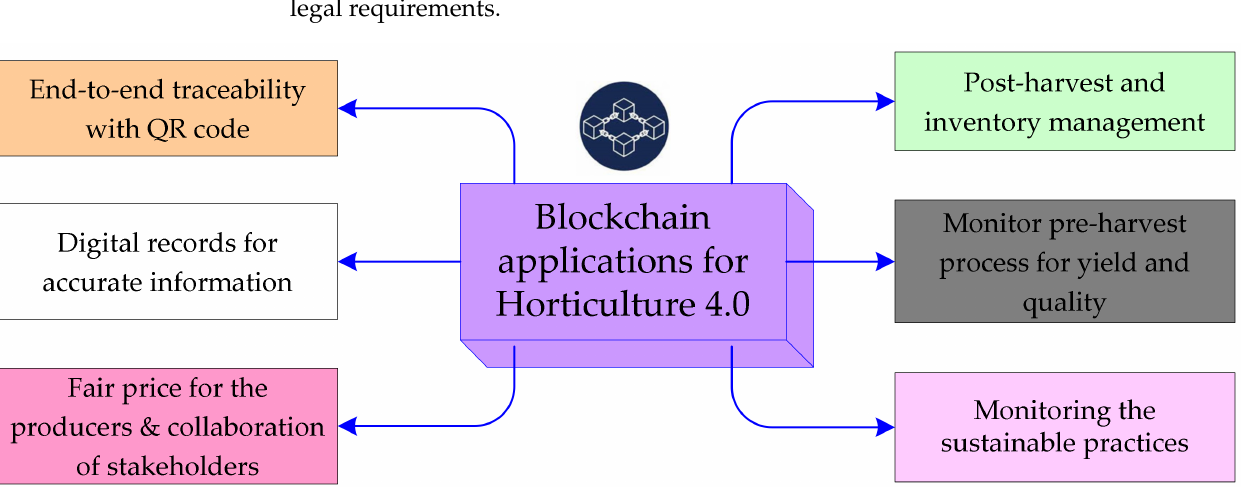
Figure 5. Applications of blockchain for Horticulture